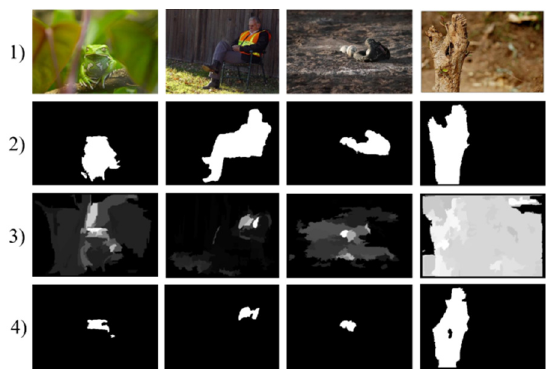
15 of 25 Figure 10. Experimental results of outer contour generation. From top to bottom rows: (1) input images, (2) saliency maps (grayscale images), (3) ground truth images, (4) ATT_Cuts results, (5) RC_Cuts results, (6) results of the proposed method, (7) boundary detection using the Canny edge